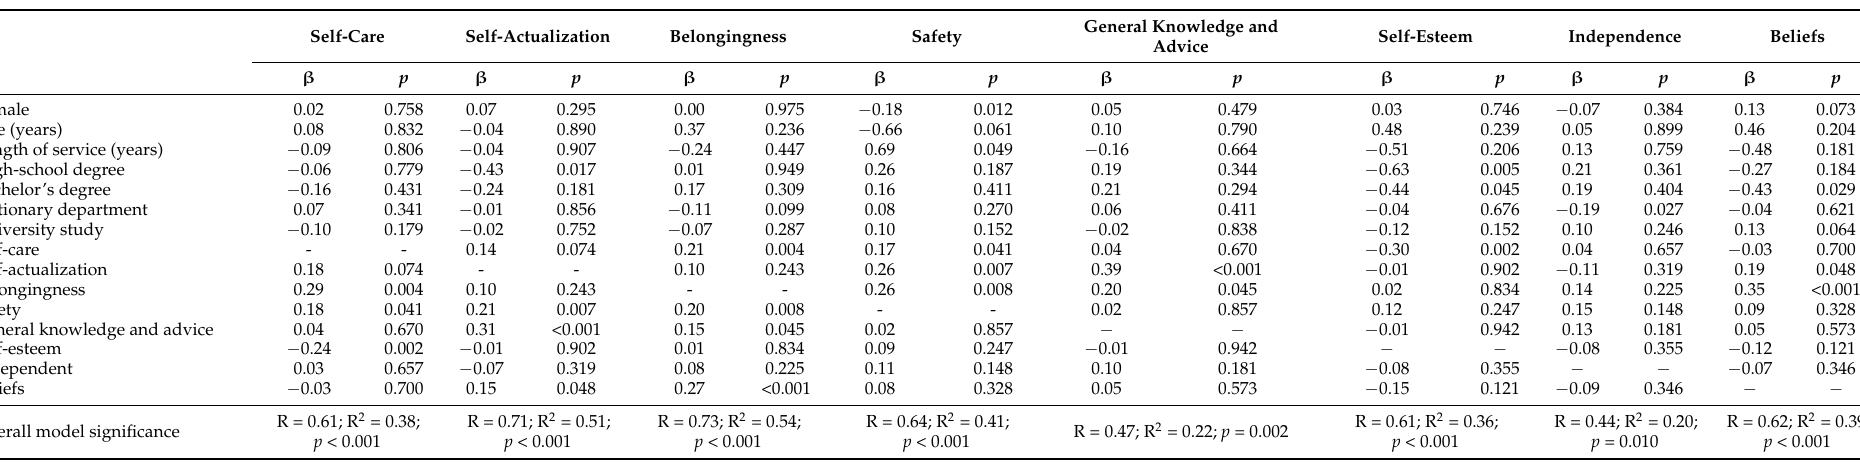
Table 4. Associations between nurses’ sociodemographic characteristics and factorial domains of knowledge about basic human needs, using linear regression